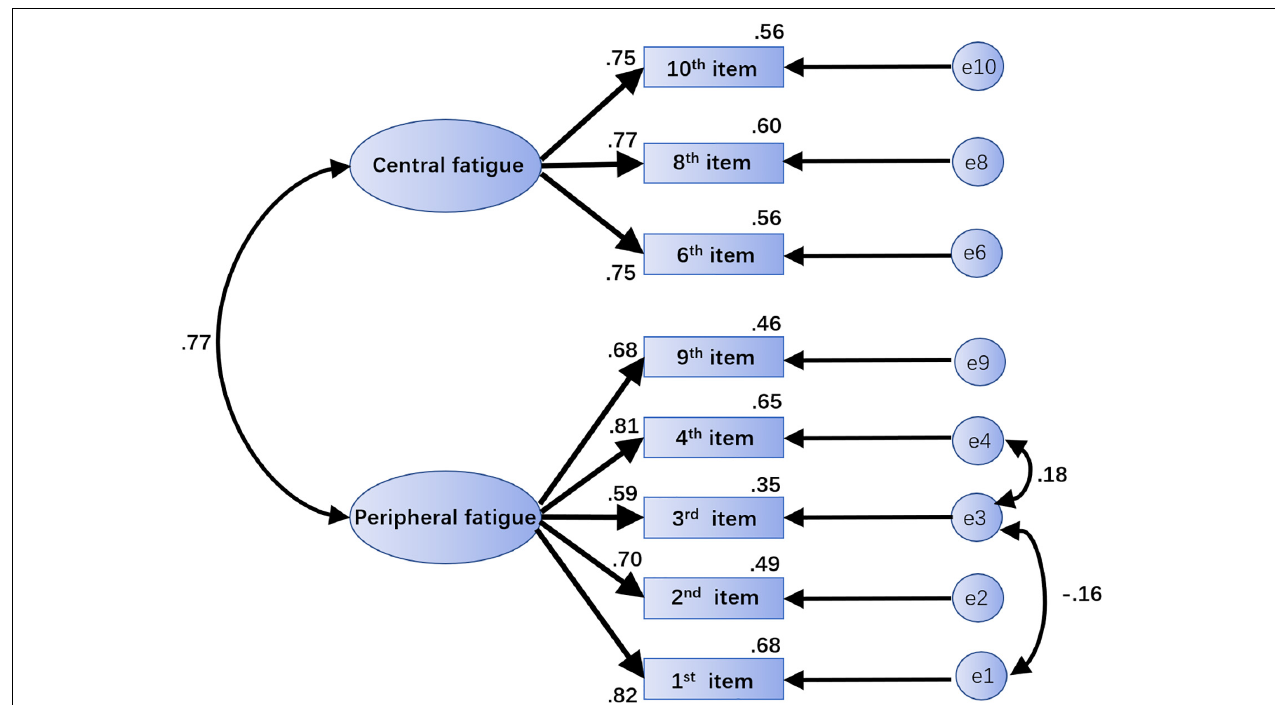
FIGURE 2 | The standardized path coefficient graph of the final structural model. The path “ → ” indicates influence or causality; the path “ ↔ ” indicates correlation or covariance. The number on each path is the standardized regression weight. Central fatigue and peripheral fatigue are latent variables. “e1,” “e2,” “e3,” “e4,” “e9,” “e6,” “e8,” and “e10” are unique variables. Paths can be added between e1 and e3 and between e3 and e4 to modify the